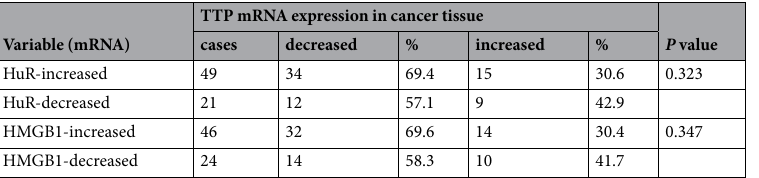
Table 1. The relationships between TTP and HuR, HMGB1 mRNAs were analyzed in 70 cases of GC